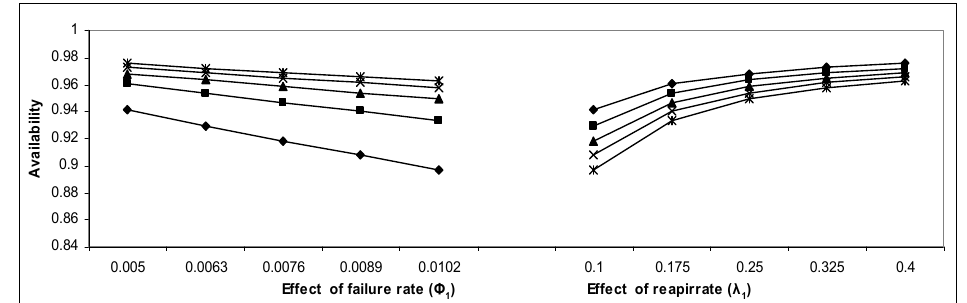
Figure 2. “Effect of failure & repair rate of heater assembly subsystem on subsystem